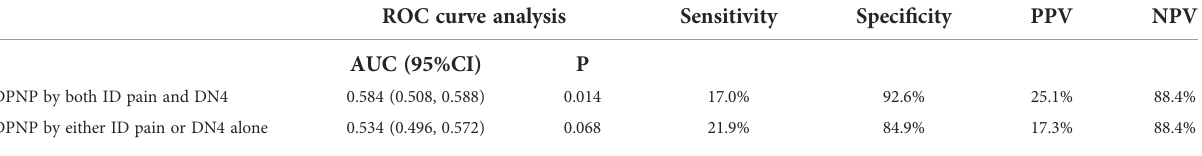
TABLE 4 Prediction of mortality by DPNP using different questionnaire criteria.